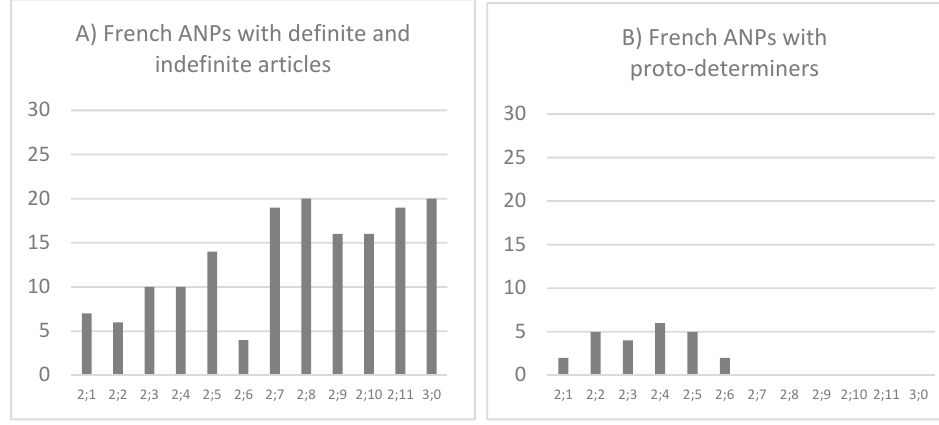
Figure 2. Frequency of use of ANPs in French-Russian, according to age .